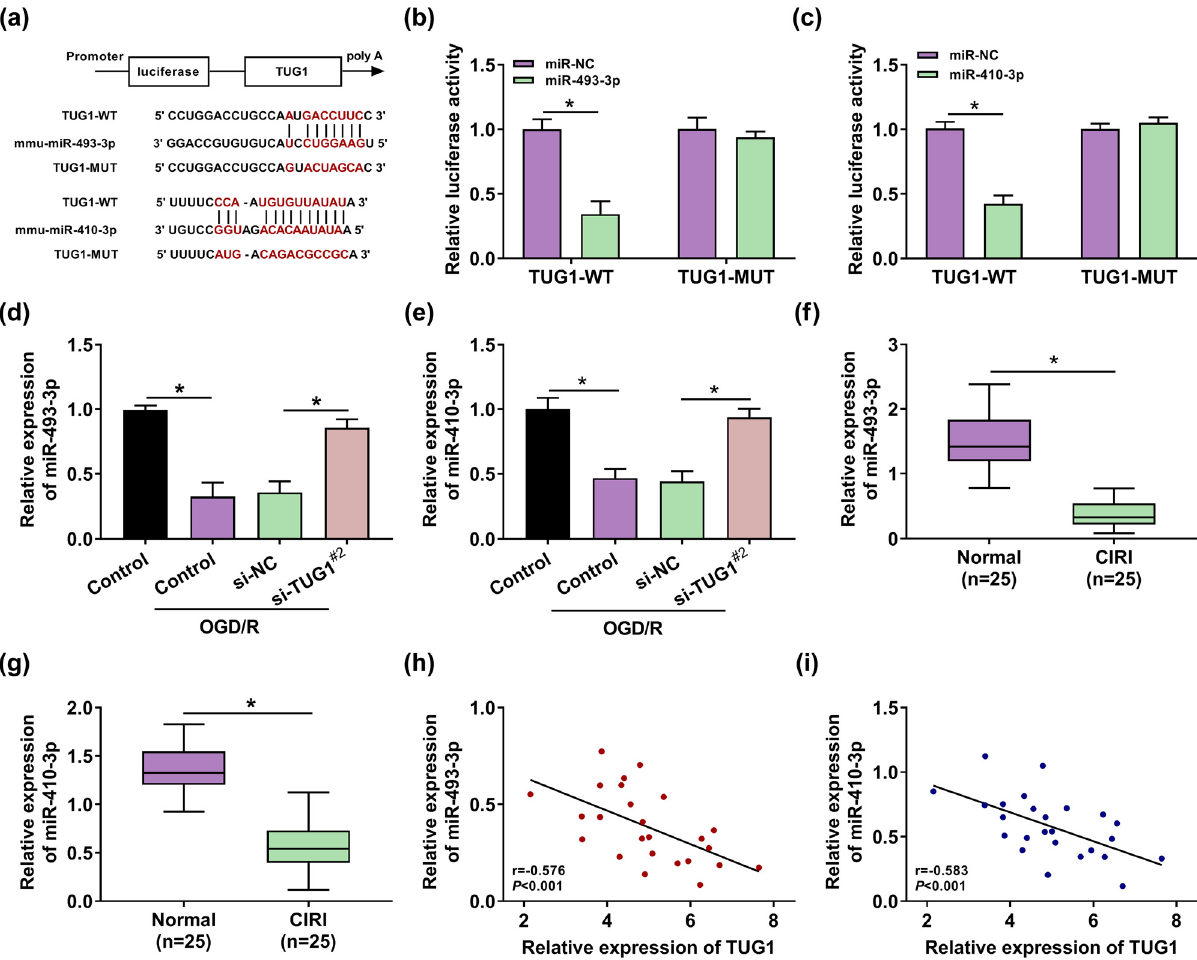
Figure 4: lncRNA TUG1 negatively regulated the expression of miR - 493 - 3p and miR - 410 - 3p by sponging miR - 493 - 3p and miR - 410 - 3p. ( a ) Online database starBase was adopted to make inferences about the underlying binding sequences between TUG1 and miR - 493 - 3p or miR - 410 - 3p in N2a cells. ( b and c ) Dual - luciferase reporter system presented the combination between TUG1 and miR - 493 - 3p or miR - 410 - 3p in N2a cells. ( d and e ) The expression of miR - 493 - 3p and miR - 410 - 3p was measured by RT - qPCR in N2a cells with or without being treated by OGD/R. ( f and g ) The expression of miR - 493 - 3p and miR - 410 - 3p was measured by RT - qPCR in the serum of CIRI patients and normal people. ( h and i ) Spearman ’ s correlation analysis was employed to analyze the relationship between the expression of TUG1 and miR - 493 - 3p or miR - 410 - 3p. * P <